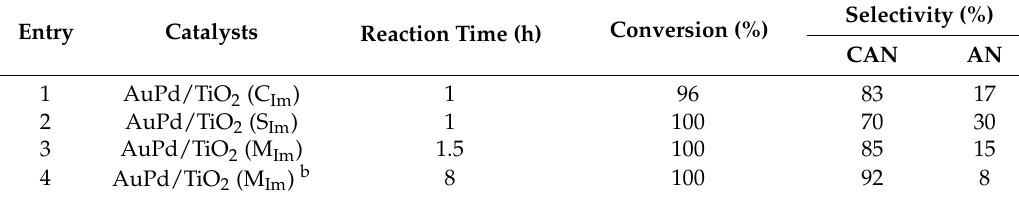
Table 3. Selective hydrogenation of 4-chloronitrobenzene over a AuPd/TiO 2 catalyst a .